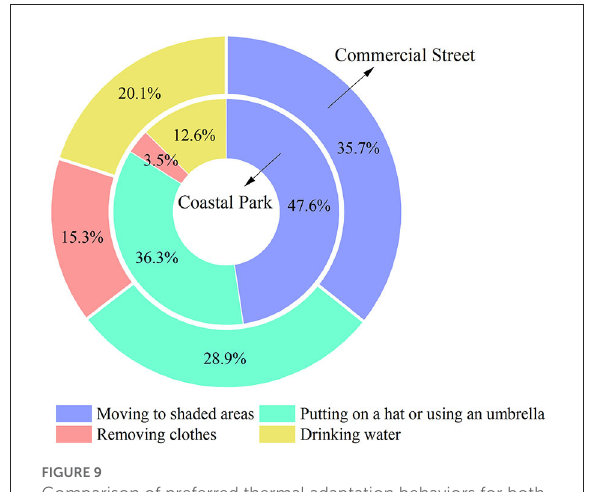
FIGURE9 Comparison of preferred thermal adaptation behaviors for both the study areas.